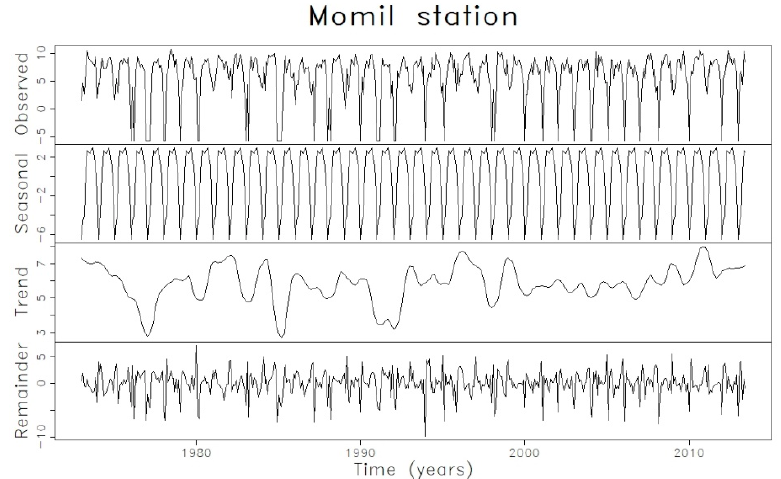
Figure 4. Calibration vector of the transformed monthly precipitation time series using Box–Cox.